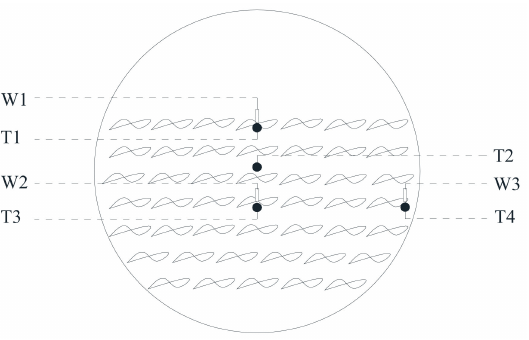
Figure 3. Distribution diagram of temperature and air speed test points. Table 1. Details of the test instruments in the combined drying system.